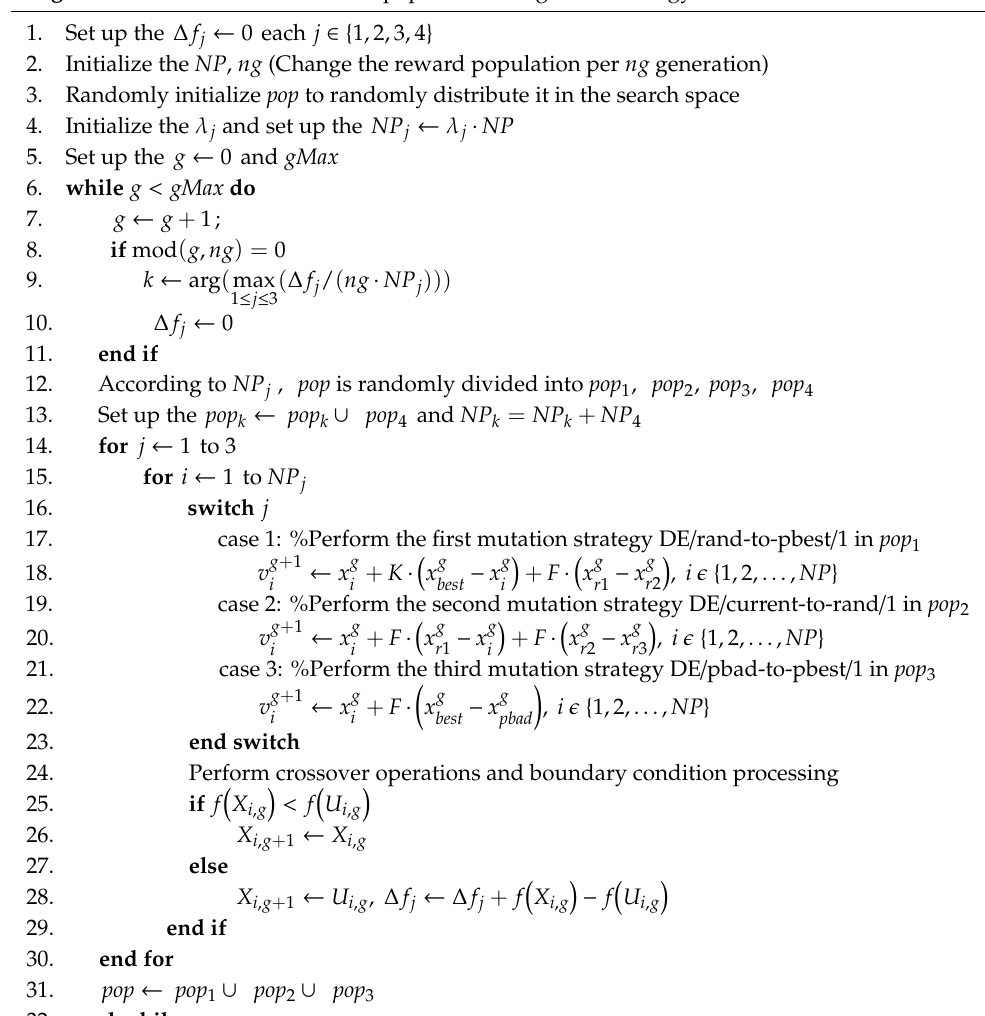
Algorithm 2. Pseudo-code of multi-population integration